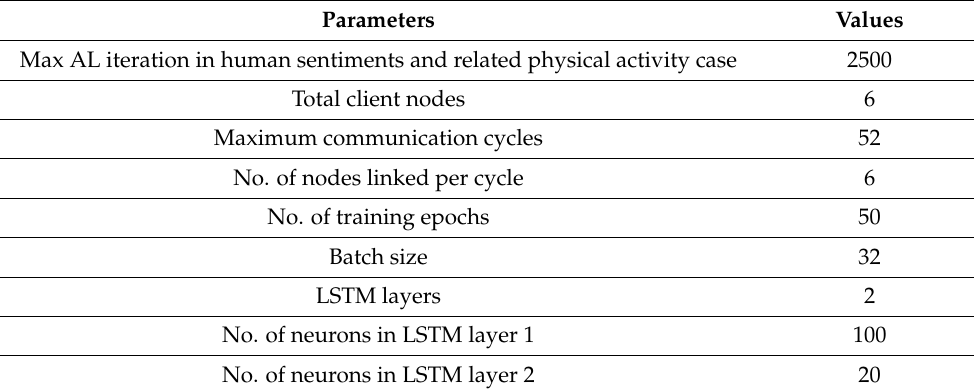
Table 4. Important parameters utilized throughout the